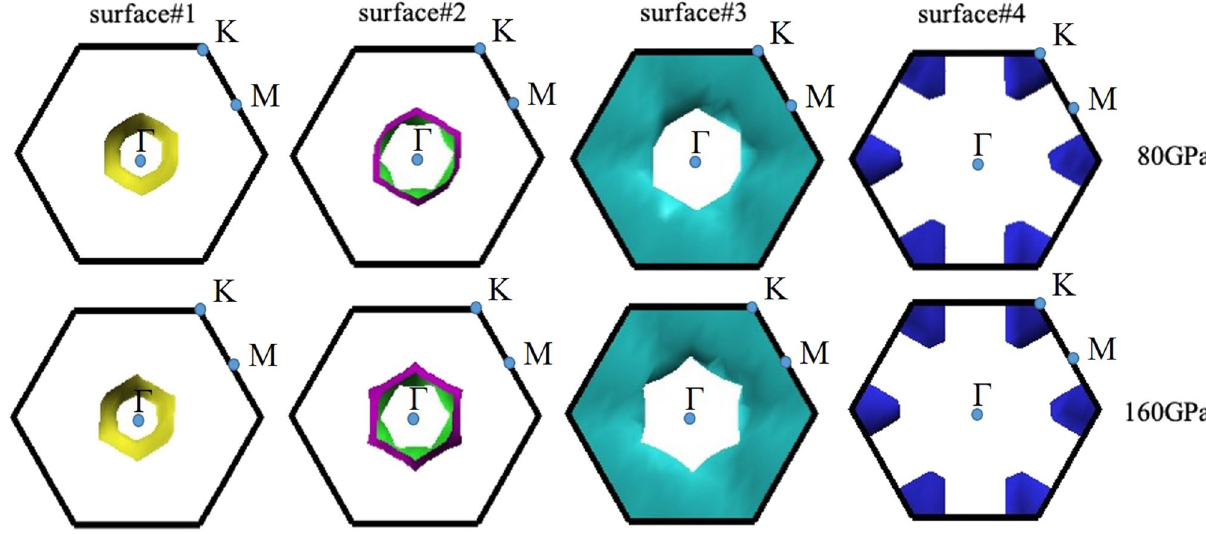
Figure 6. Sketch of FST of P6 3 /mcm at 80 and160 GPa, respectively (drawn by XCrySDen program (ver. 1.5.60) 66 (URL http://www.xcrys den.org/Downl